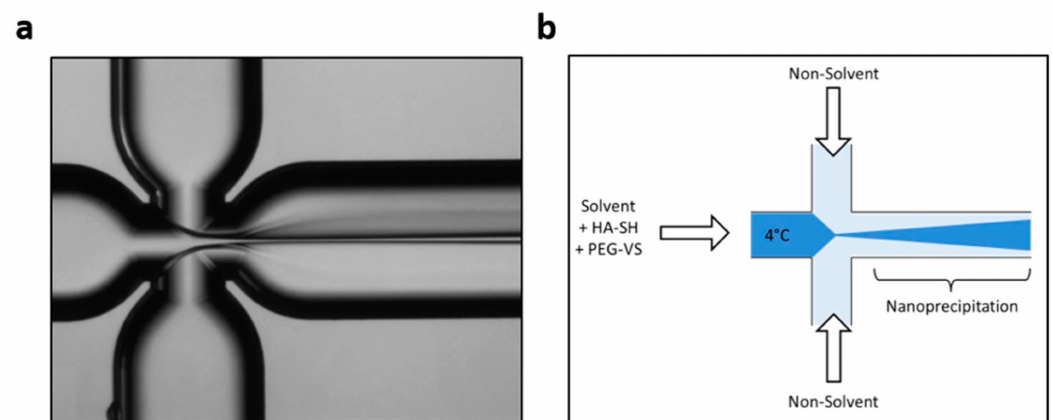
Figure 5. Schematic illustration of the microfluidic experimental setup used by Tammaro et al. ( a ) Optical Fluorescence Microscopy Image of Flow-Focusing pattern; ( b ) Qualitative Illustration of crosslinking strategies. Reprinted from an open-access source [52].